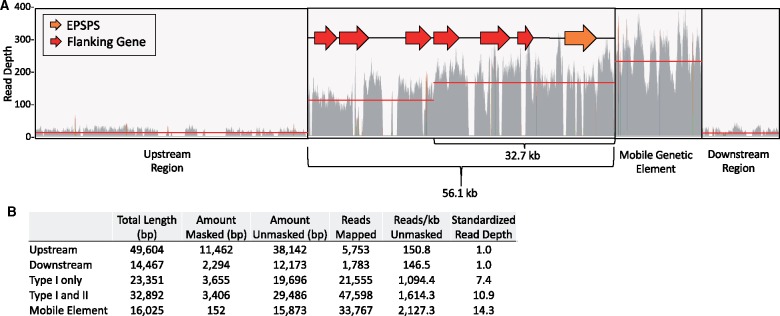
—(A) Illumina shotgun genome resequencing data from a resistant kochia plant aligned to four distinct units from the BAC assembly: 1) The region directly upstream of the EPSPS tandem duplication, 2) the tandemly duplicated region of the genome containing EPSPS, 3) the MGE, and 4) the region directly downstream of the EPSPS tandem duplication. Red lines indicate the average read depth for that unit. Two averages are indicated for the tandemly duplicated region of the genome containing EPSPS due to two major repeat sites existing in the EPSPS CNV structure: the 56.1- and 32.7-kb repeat types. (B) A table outlining the calculation for copy number estimates for the four units. The total length of the region, the amount of repetitive DNA that was masked, the amount of DNA remaining unmasking, the number of reads mapped to the unmasked regions, the average reads per kilobase of unmasked DNA, and the read depth divided by the reads/kb unmasked of the nonduplicated region.